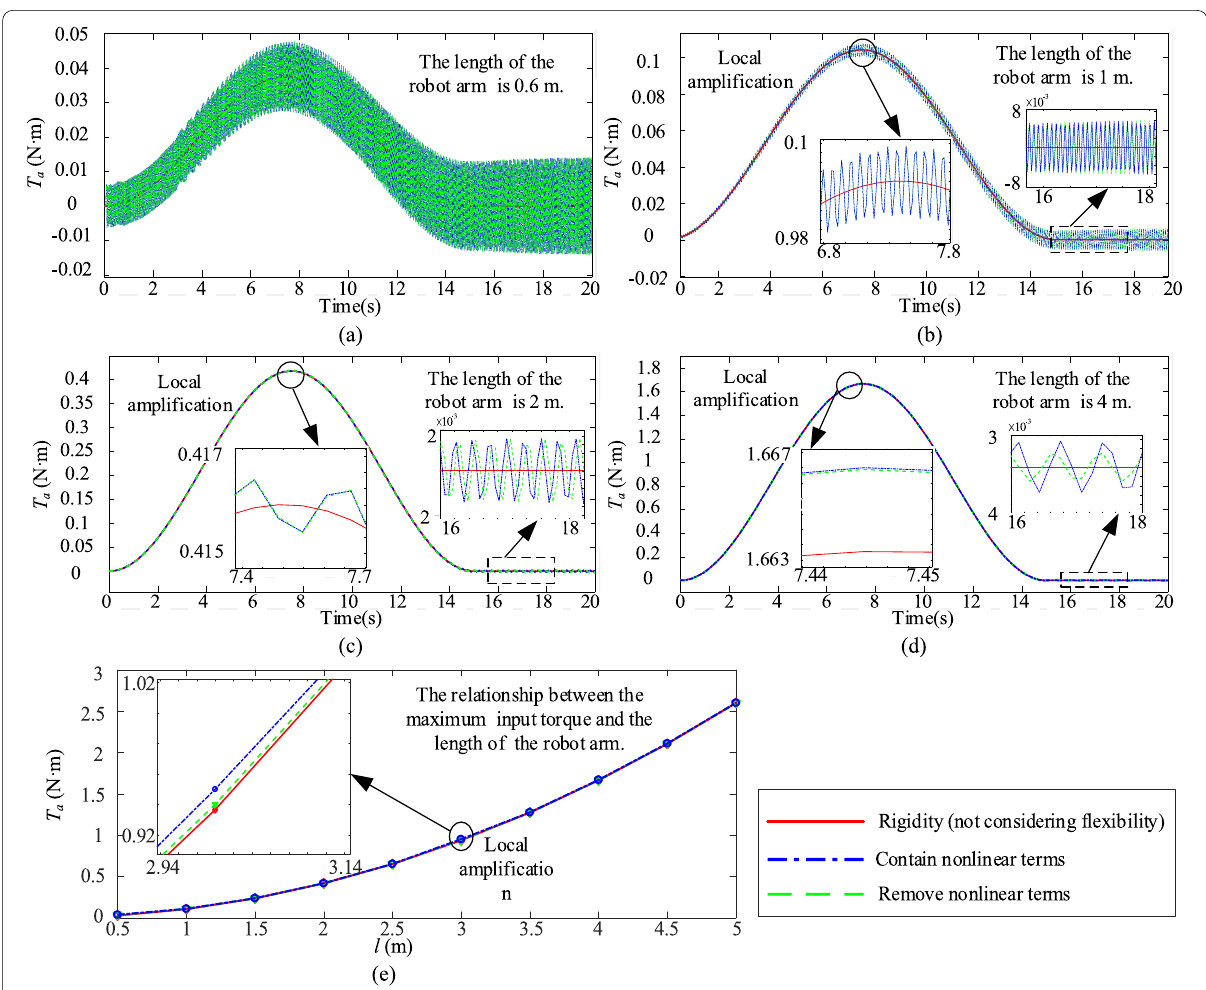
Figure 11 Influence of the manipulator’s length on input torque: ( a ) Simulation results when the length is 1 m, ( b ) Simulation results when the length is 2 m, ( c ) Simulation results when the length is 3 m, ( d ) Simulation results when the length is 4 m, ( e ) Relationship between maximum input torque and